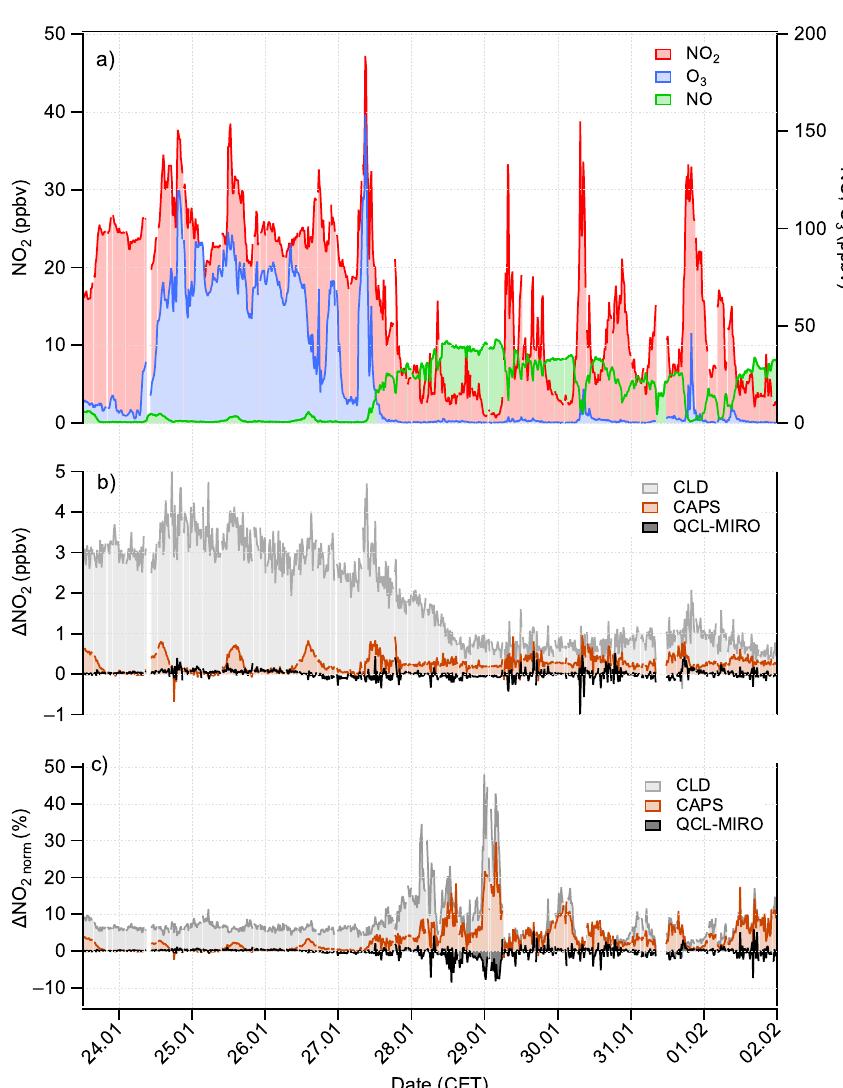
Figure 8. Time-series measured during the field campaign: ( a ) ambient NO 2 (measured by the QCL- Empa with the CDC calibration factor), NO (measured by the CLD) and O 3 ; ( b ) absolute differences between NO 2 measured by the CLD, CAPS and QCL-MIRO and the QCL-Empa; and ( c ) absolute differences normalized by the NO 2 (QCL-Empa) values (the CLD data being further divided by two, for better